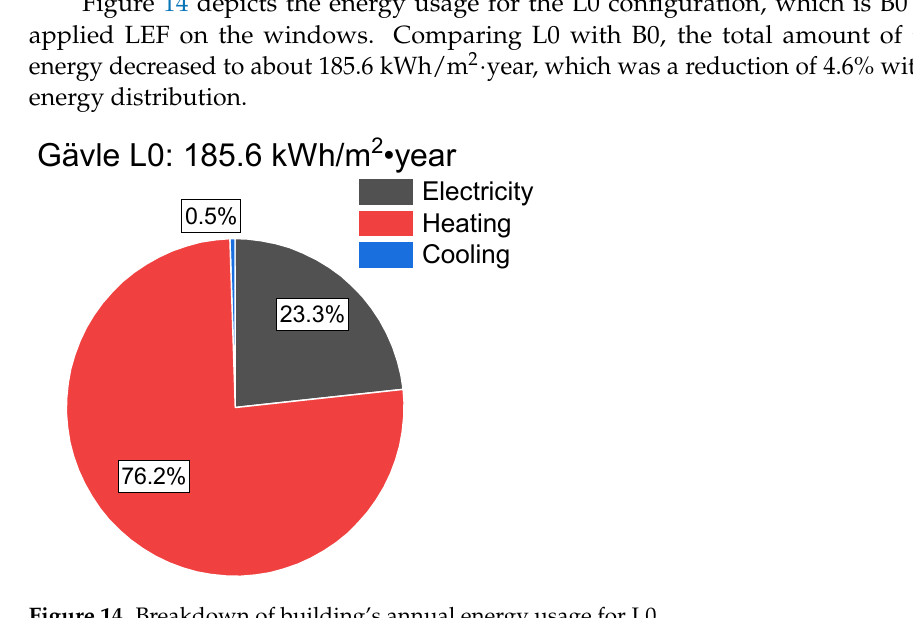
Figure 14. Breakdown of building’s annual energy usage for L0.